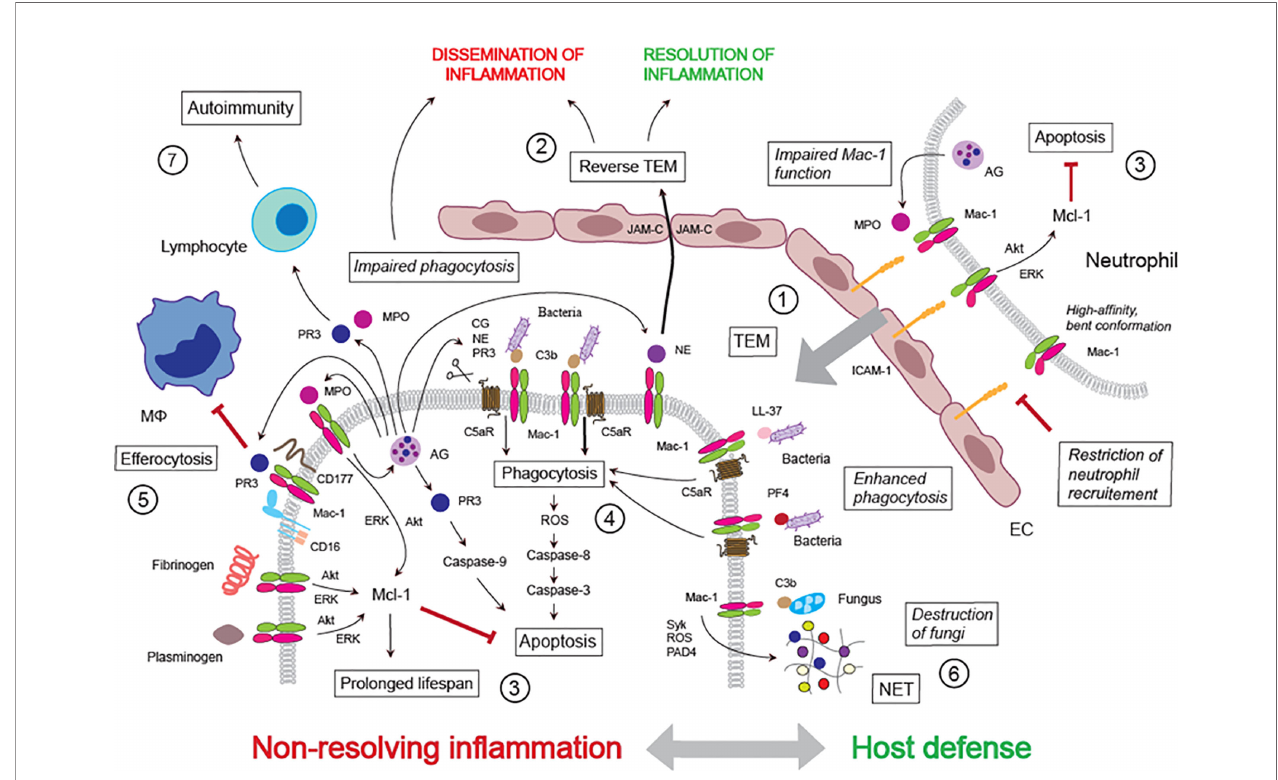
FIGURE 1 | Mac-1 ligand repertoire shapes host defense and non-resolving in fl ammation. ① Transendothelial migration : Mac-1, together with LFA-1, mediates neutrophil adherence to the activated endothelium and transmigration. Conformational changes in Mac-1 (high af fi nity, bent conformation) and MPO impairment of Mac-1 function may limit neutrophil traf fi cking. ② Reverse TEM : Mac-1-bound NE direct neutrophil reverse TEM through binding to and cleaving JAM-C. ③ Neutrophil lifespan : Ligation of Mac-1 with ICAM-1, fi brinogen, plasminogen or MPO generates survival signals for neutrophils through delaying constitutive apoptosis. MPO induces MPO release from the azurophilic granule, thereby forming a feed-forward loop. ④ Phagocytosis: Phagocytosis of complement C3b-opsonized bacteria induces PICD followed by efferocytosis. Cleavage of C5aR (CD88) by NE, PR3 or cathepsin G (released from the azurophilic granule) alters the Mac-1/C5aR ratio, impairs phagocytosis, bacterial clearance and PICD. ⑤ Inhibition of efferocytosis : PR3 bound to Mac-1(in association with CD16 and CD177) inhibits efferocytosis. ⑥ NET release : C3b-opsonized fungus or immobilized fungal b -glucan, which cannot be phagocytosed, evokes release of NET, leading to extracellular killing of the pathogen. ⑦ Autoimmunity : PR3 and MPO (presented by Mac-1 and/or NET) may induce